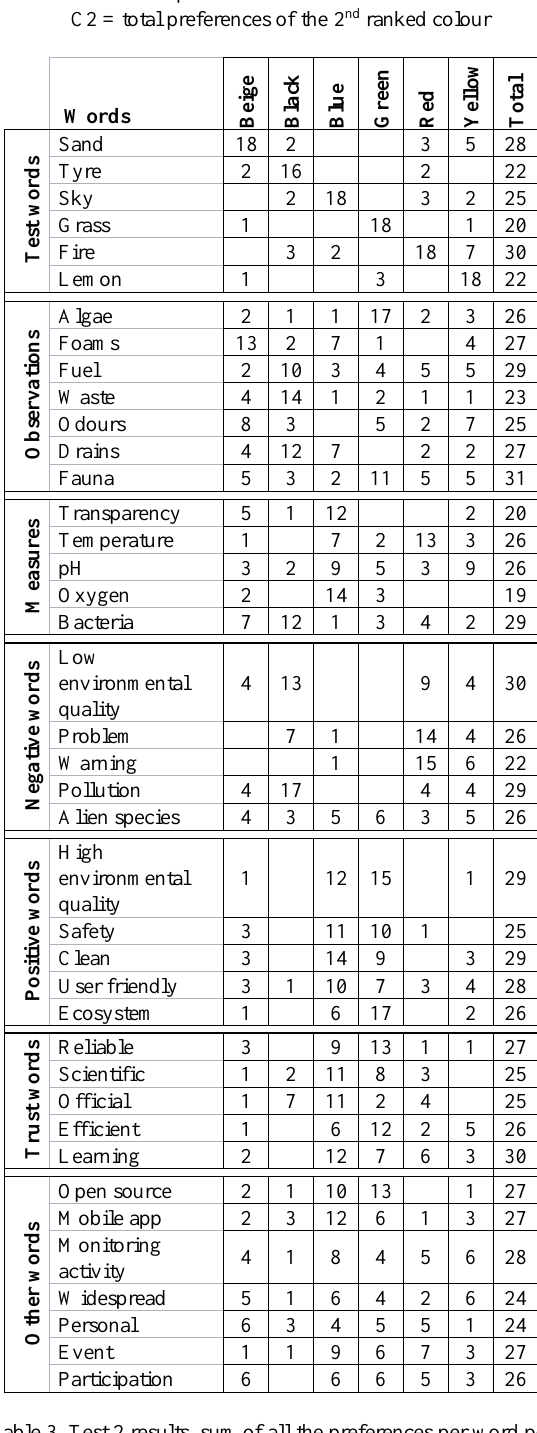
Table 3. Test 2 results, sum of all the preferences per word per colour and total number of preferences of the word For C1/Pmin high values mean strong associations between word and colours. For Pmin/Ptot, high values mean a question with few alternatives per answer where participants mainly expressed only one preference. For C2/C1, low values mean predominance of one colour over the others and a non-dualistic majority.As expected, the values of C1/Pmin for the test